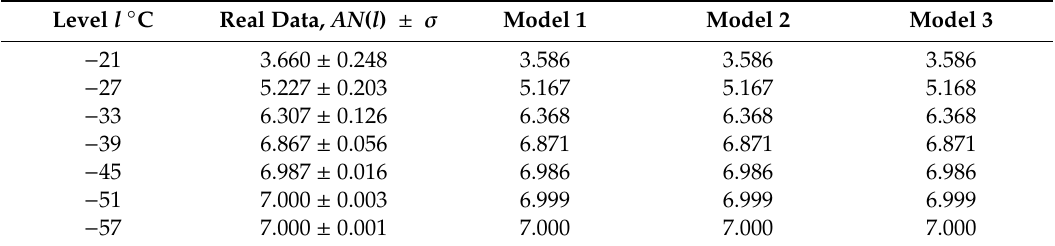
Table 1. The average number, AN ( l ) , of stations in the area where the average daily WCI was above the given level l , Area 1, 15